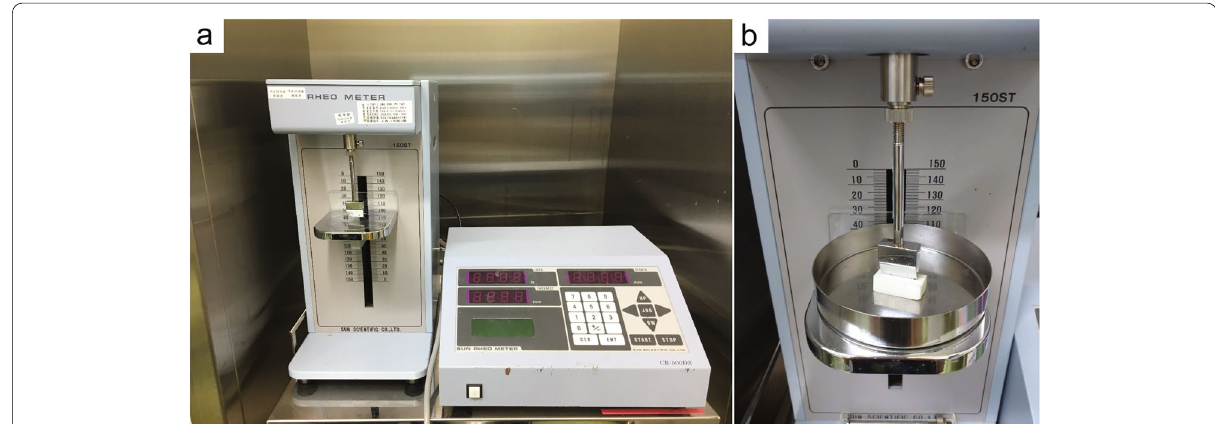
Fig. 1 a Hardness meter with special adaptor used to obtain the measurements. The plaque was placed on the measurement table and measured by applying pressure using a special adaptor. b The special adaptor compresses and measures the